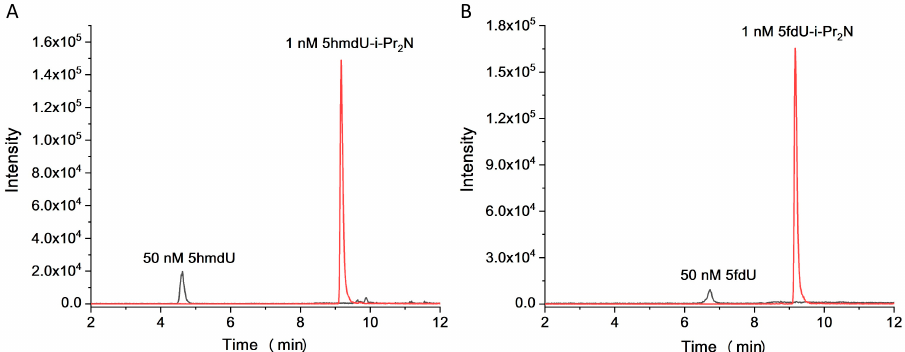
Figure 2. Extracted ion chromatograms of unlabeled and i-Pr 2 N-labeled products of ( A ) 5hmdU and ( B ) 5fdU. The amounts of unlabeled 5hmdU and 5fdU were 50 nM (250 fmol), and the amounts of i-Pr 2 N-labeled products were 1 nM (5 fmol), respectively.